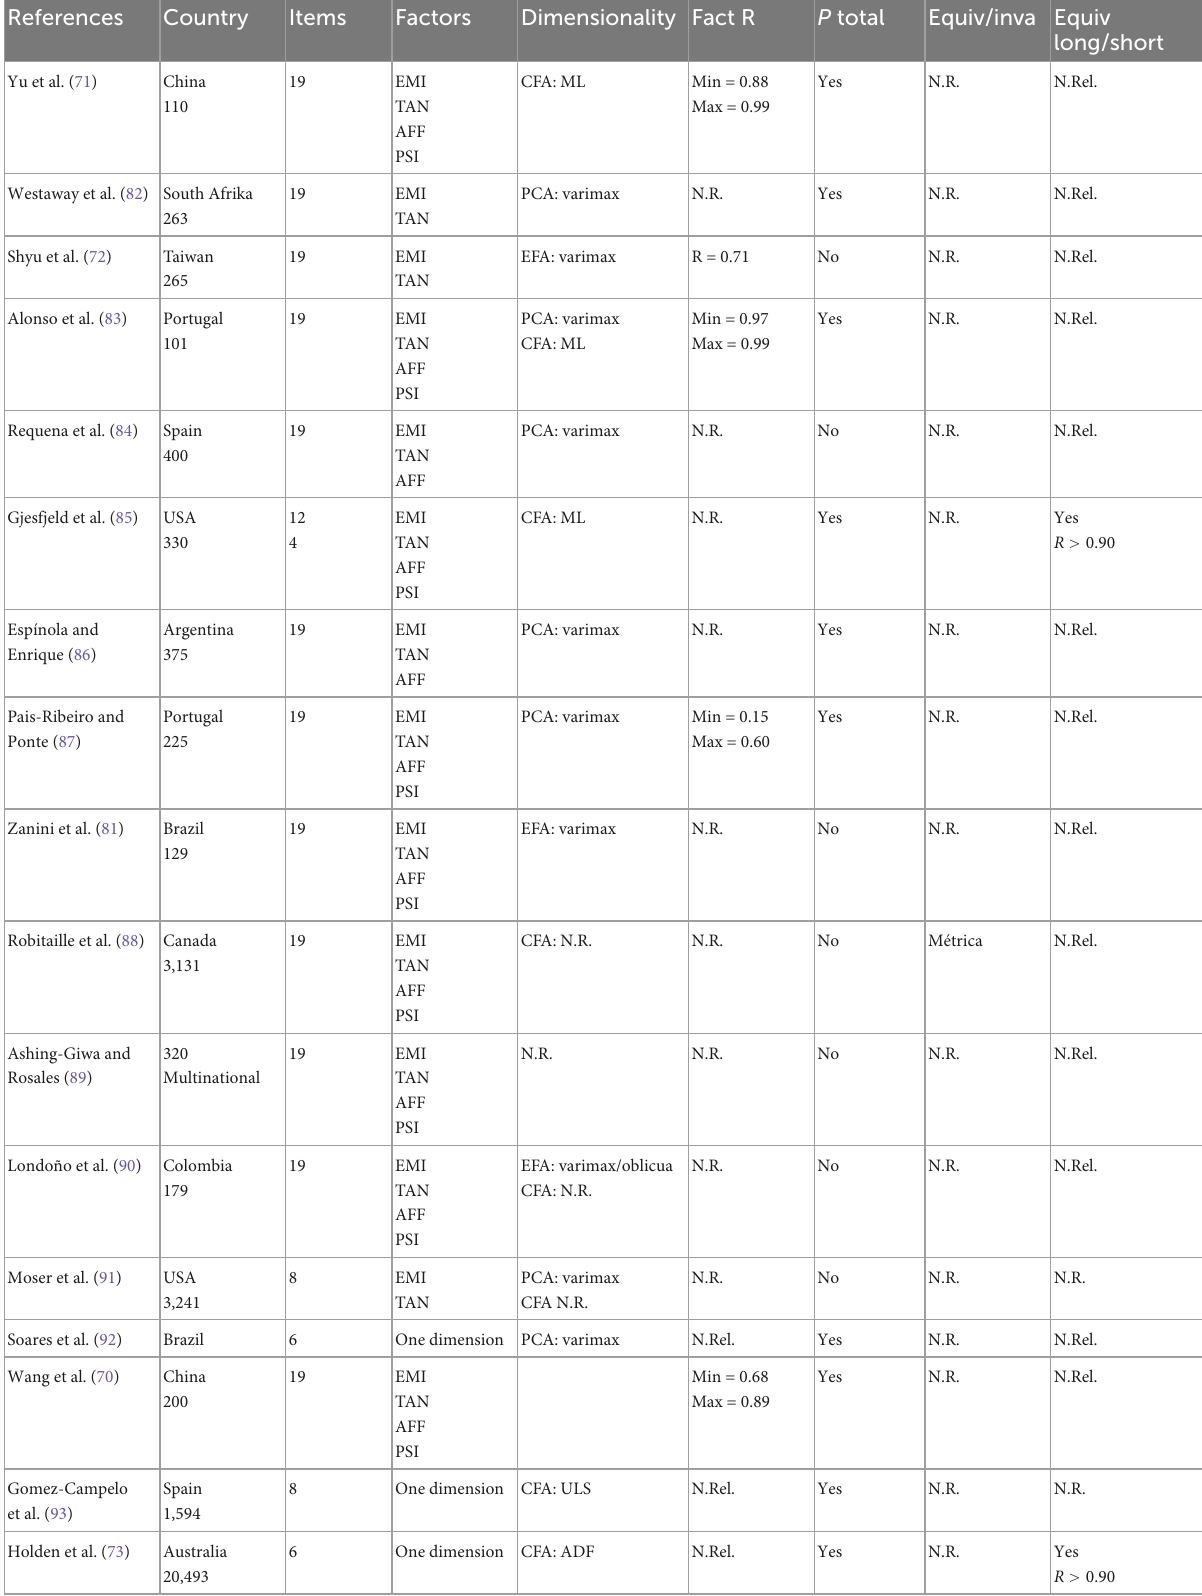
TABLE 1 Review of MOS-SSS validation studies for evidence of internal